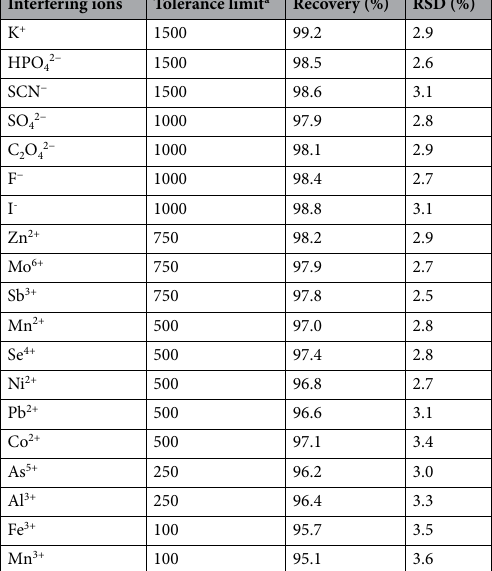
Table 3. Tolerance limits of interfering ions for determination of 40 ng L −1 As(III) after application method. a [Interfacing